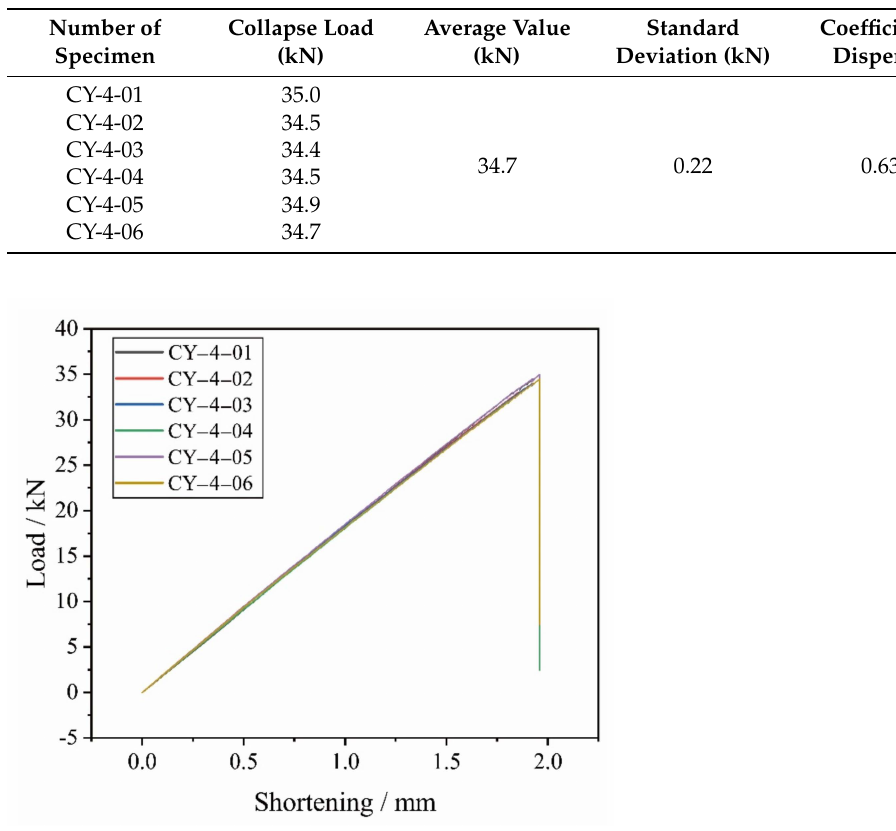
Table 12. Experimental results of the T300/Cycom970 fabric open-hole laminates.